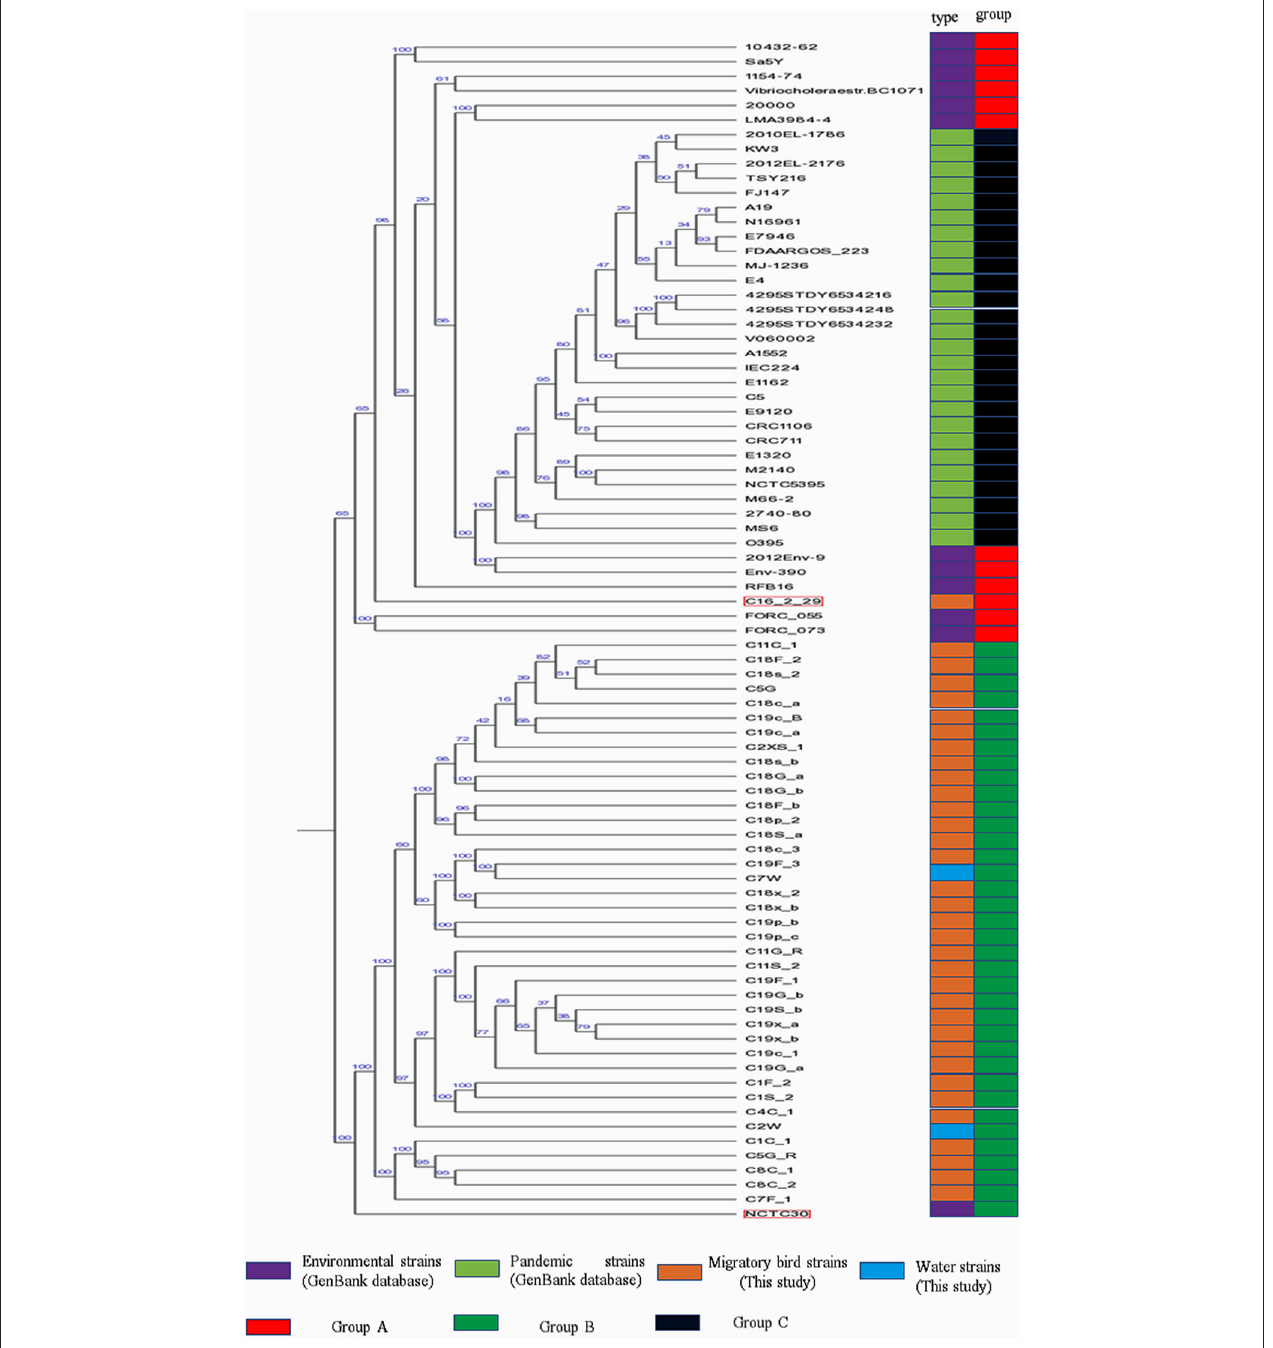
FIGURE 2 | Phylogenetic analysis of V . cholera strains. Different colored blocks are used to indicate types and groups of strains on the left of phylogenetic tree. The color legend is shown below the phylogenetic tree.